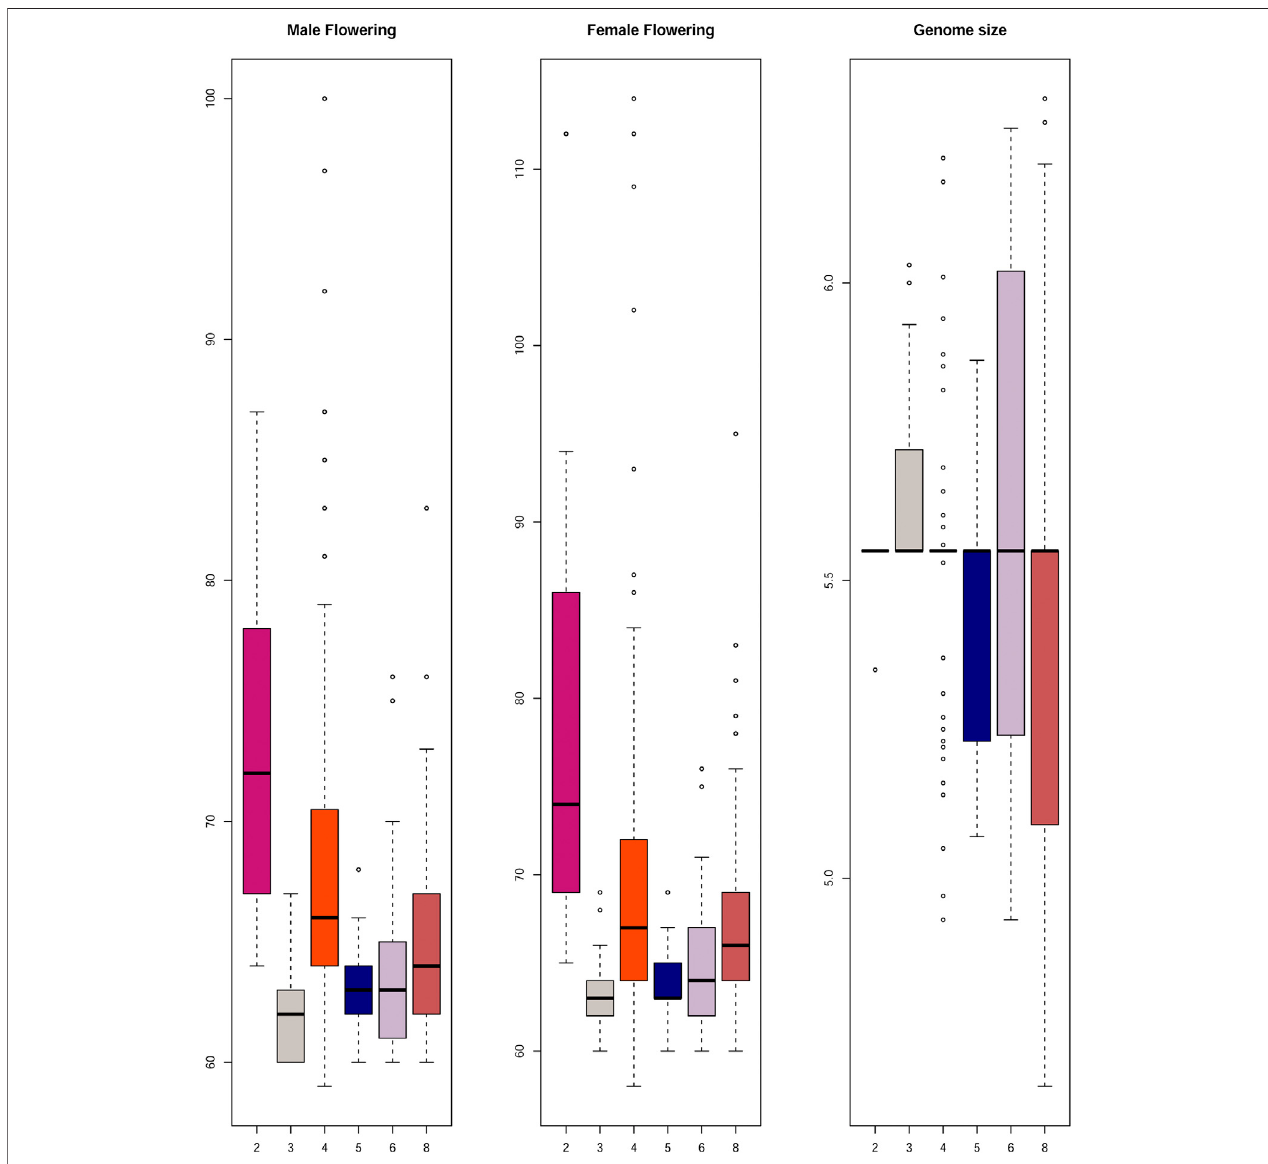
FIGURE 5 | Comparison between total knob number and male and female fl owering time, and genome size. The fl owering time is expressed in days to fl owering and genome size in picograms ( y axis). The numbers on the X axis refers to the sum of the total number of knobs (dosage class) from chromosomes 3, 5, 7 and 9.